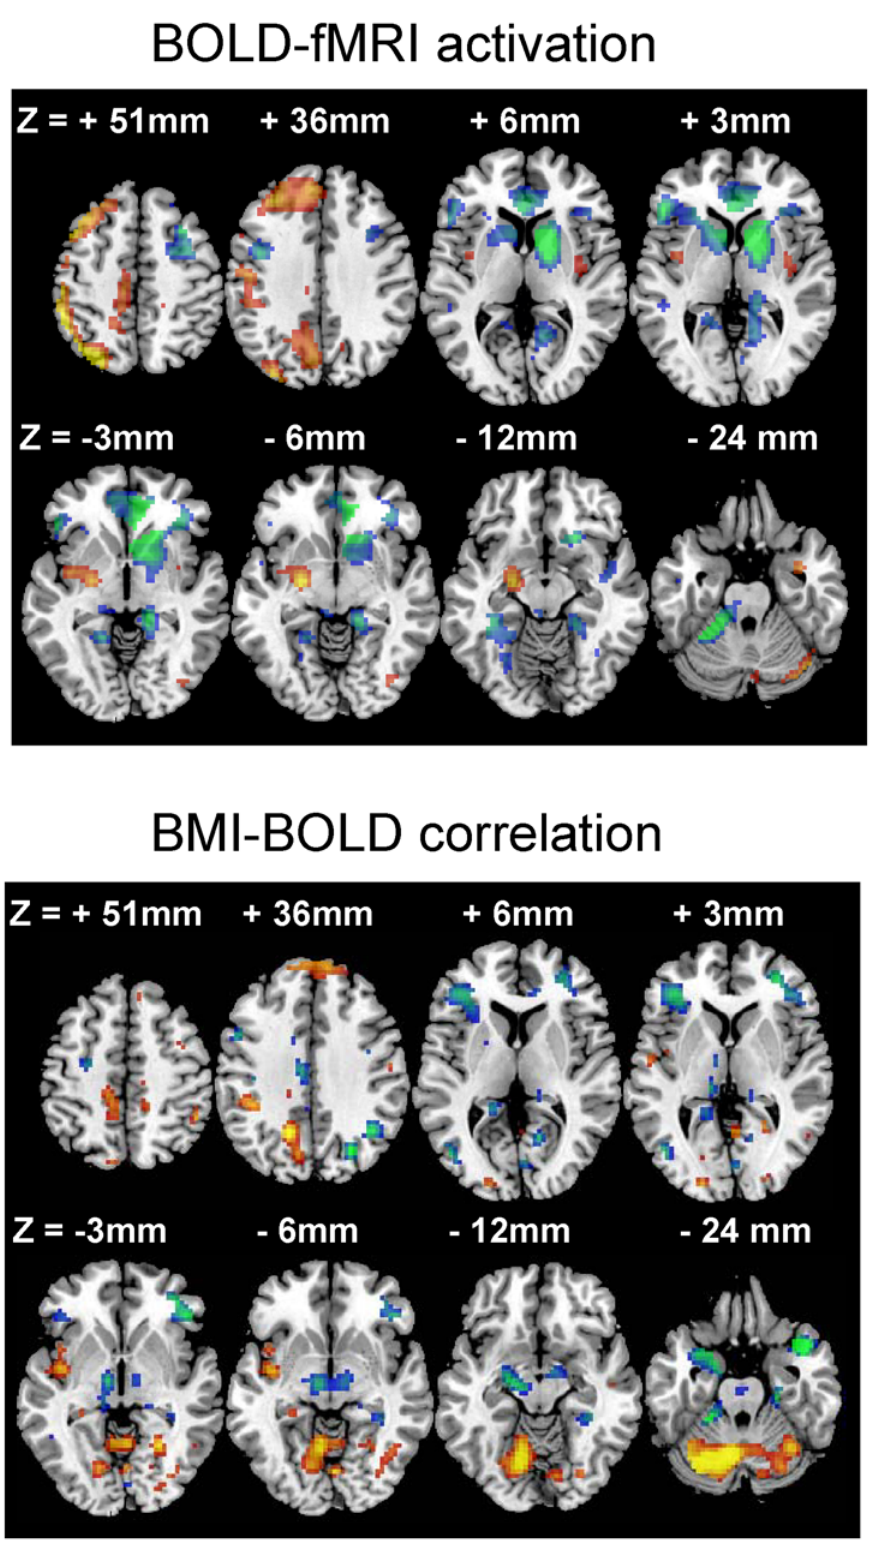
Figure 3. Brain activation during gradual gastric distention (GD). Top panel: Statistical maps showing regions with significant brain activation (red-yellow) and deactivation (blue-green) during gradual GD. Bottom panel: correlations between BMI and BOLD-fMRI responses in the brain during gradual GD. Threshold for statistical significance: P corr , 0.05 corrected for multiple comparisons using the family-wise error (FWE) correction. Sample: 24 healthy controls. Data from all 47 GD1 and 43 GD2 fMRI runs were included in SPM2 multiple regression analyses. Activation/ correlation patterns reflecting the effect of volume were not significant in any brain region.